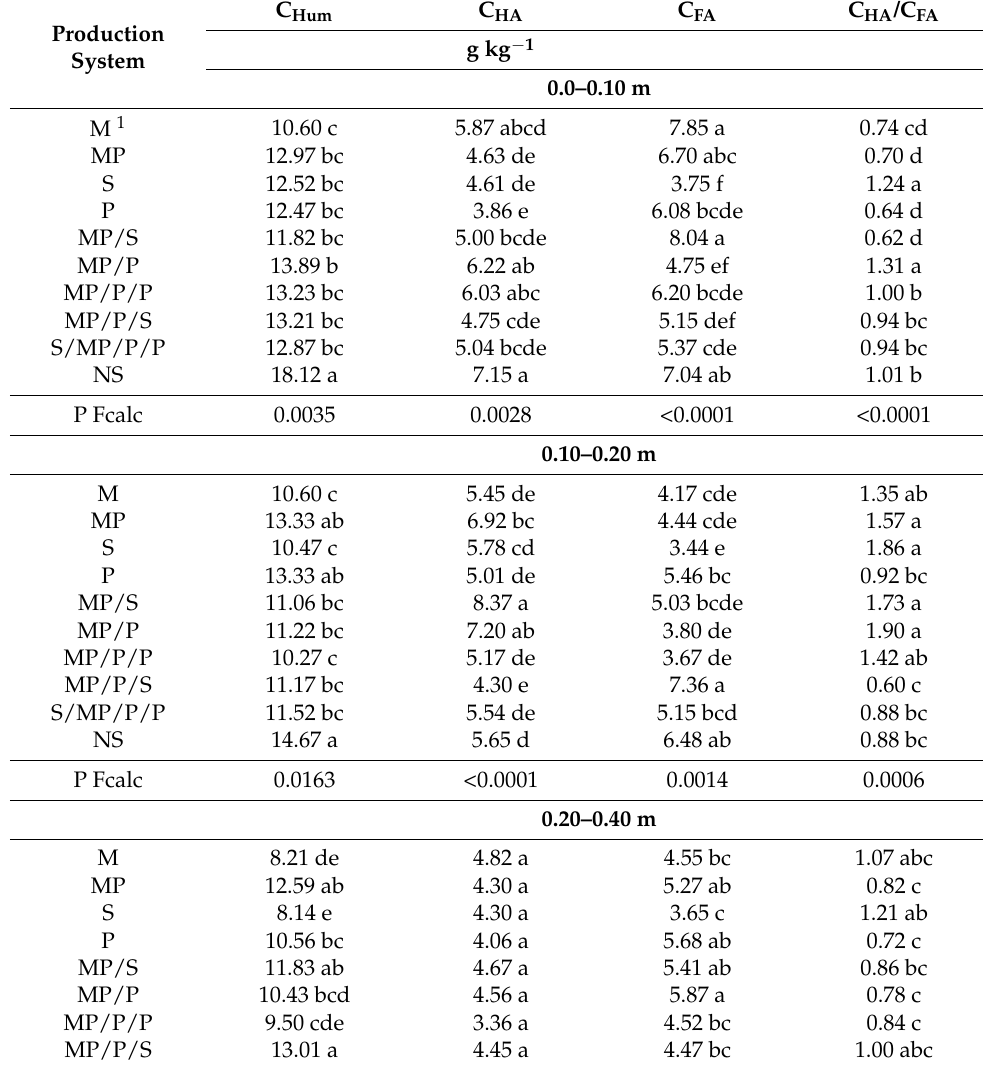
Table 5. Organic carbon content in the chemical fractions of soil organic matter: Humin (C Hum ), humic acid (C HA ), fulvic acid (C FA ) and CHA/ CFA ratio in layers 0.0–0.10, 0.10–0.20 and 0.20–0.40